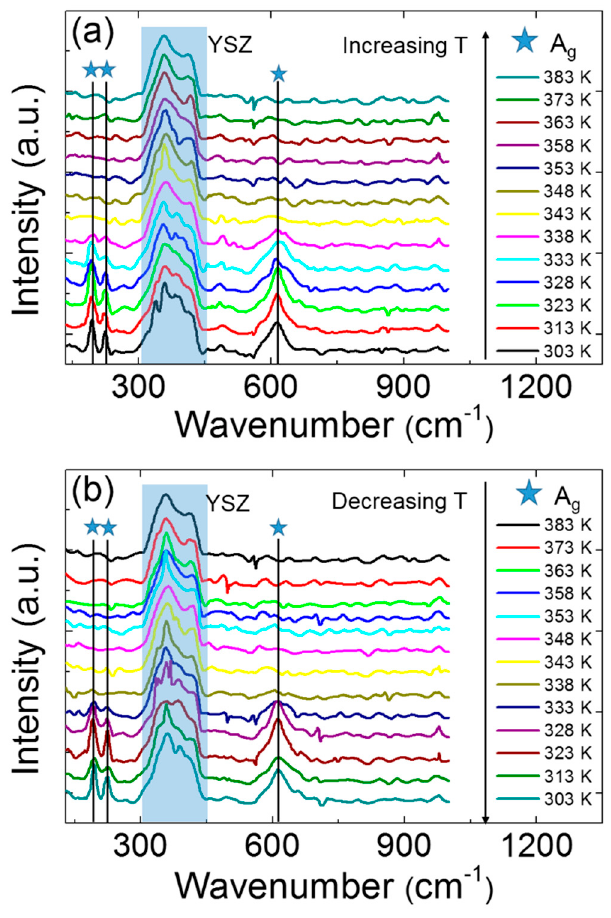
Figure 3. Raman spectra in the cases of increasing ( a ) and decreasing ( b ) temperature. The stars labelled in the figure represent the A g modes in the VO 2 thin films. The shade boxes show the Raman signals from the YSZ substrates.